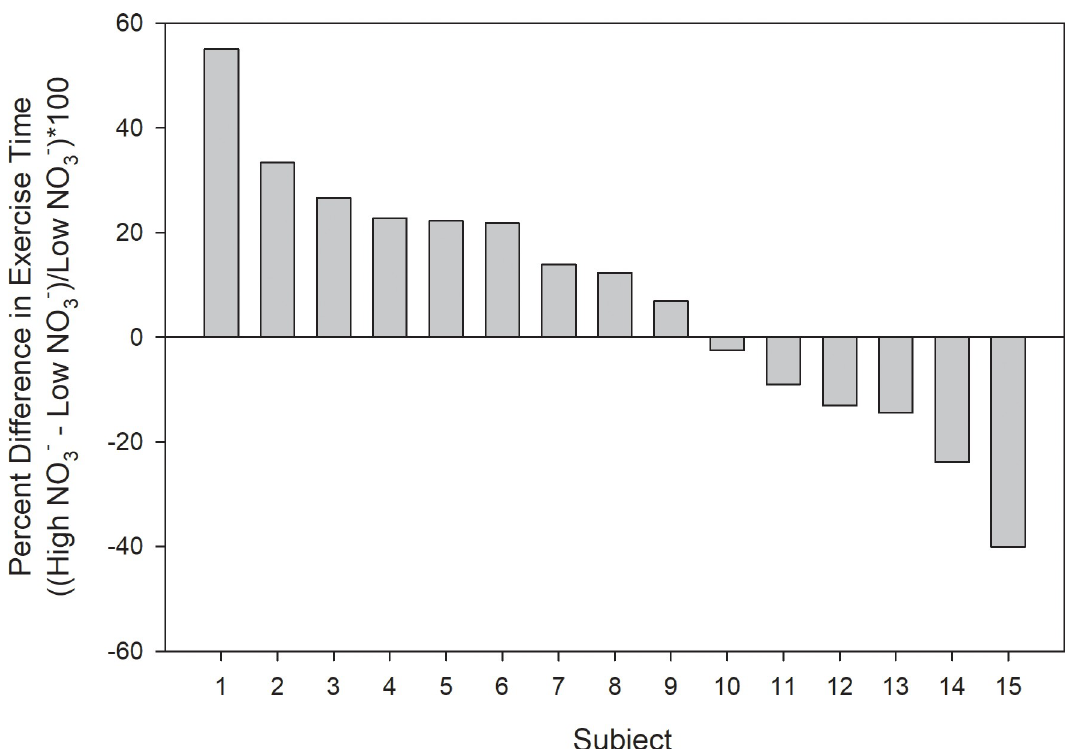
Fig 5. Individual subject responses. Bars represent individual subject responses that ranged from a 55 percent improvement in exercise time during the high NO 3- beverage trial as compared to the low NO 3- beverage trial to as low as a 40 percent decrement in